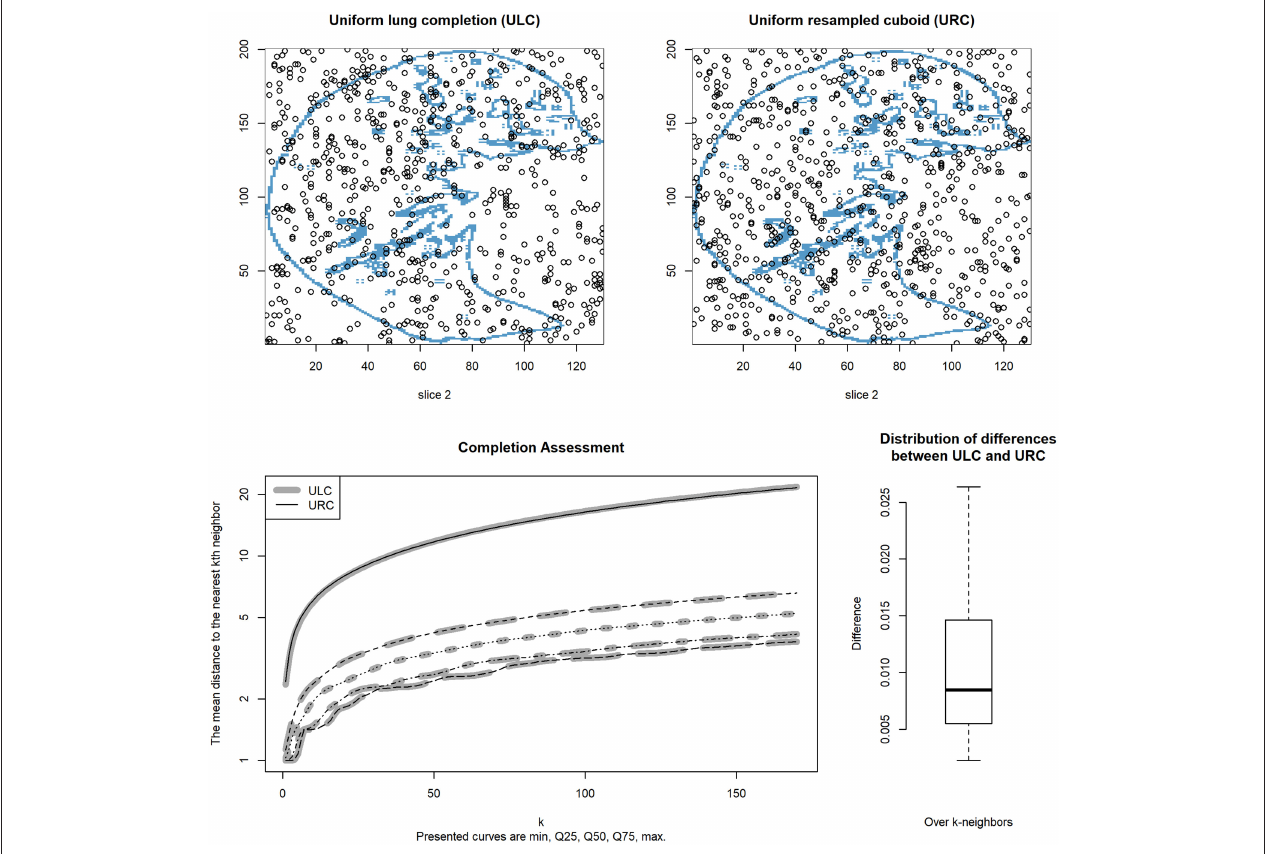
FIGURE 2 | Mean distance to the k th nearest neighbor vs. k for 200 simulations. Curves for the uniform lung completion (ULC) are indicated in gray and are superimposed on those for the uniform resampled cuboid (URC) in black; they very closely overlap. The five curve positions (from bottom to top) represent the minimum, 25% quartile, median, 75% quartile, and maximum, respectively, for mean distances between ULC and URC curves over the 200 simulations. The top left CT scan contains a uniform point repartition inside the segmented lung and is completed on the cube with the method. The top right image is a uniform point repartition over the data. The bottom right graphic represents the knn difference distribution between the completed and the uniform point pattern distribution.